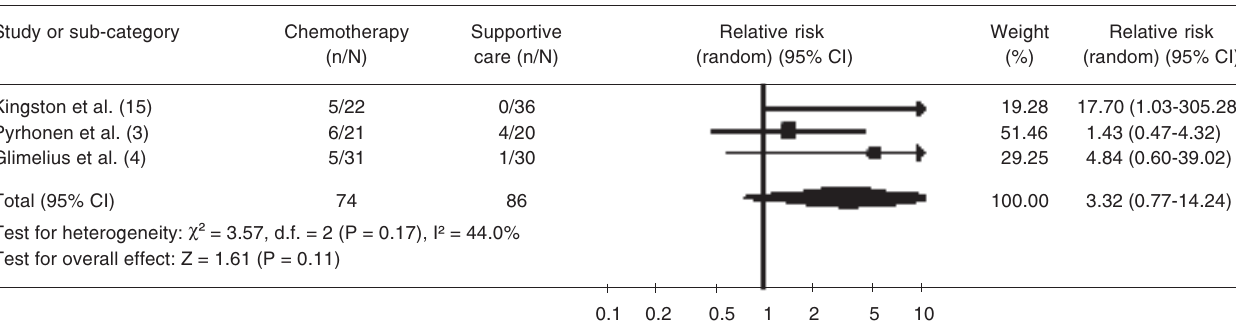
Table 4. Objective